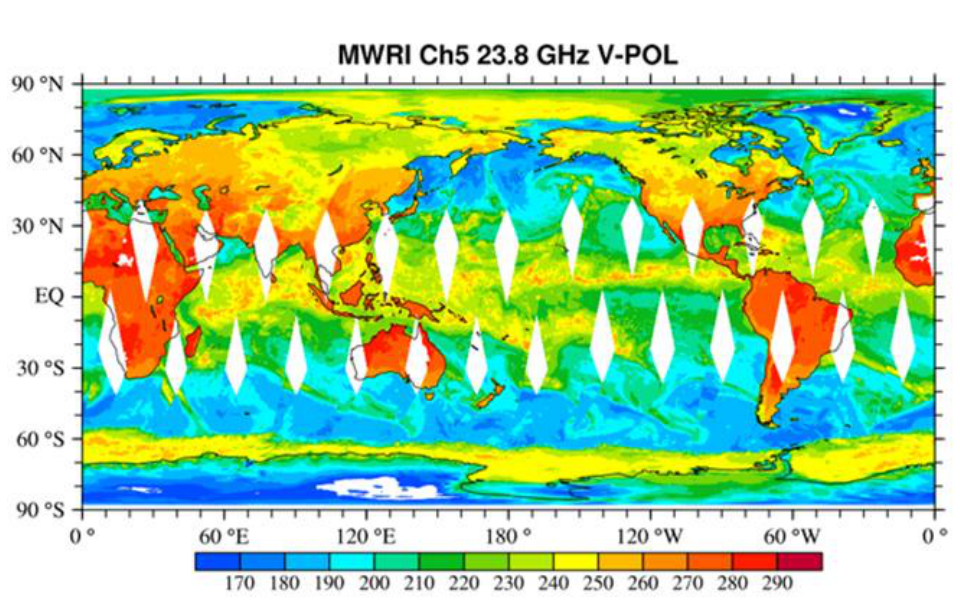
Figure 1. The coverage of channel 5’s scanning in one day. MWRI weighting functions calculated from the U.S. Standard Atmosphere model channels’ peaks were located at surface levels, which meant a clear sky atmosphere was transparent for the MWRI